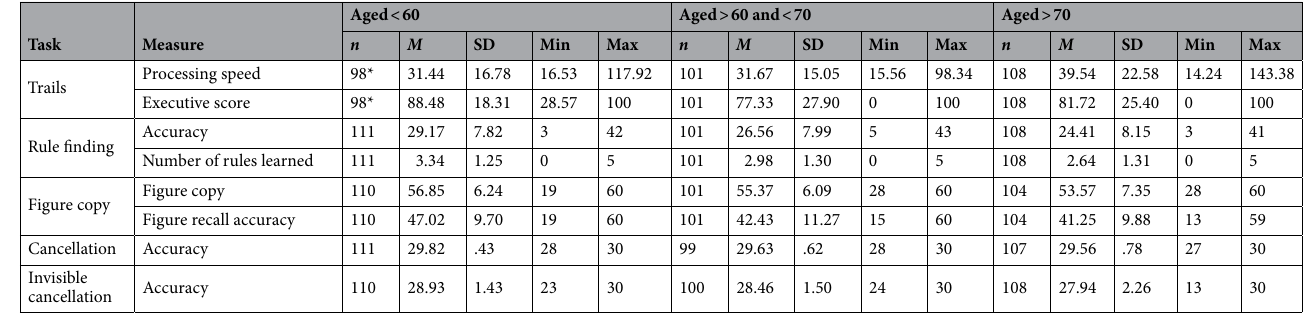
Table 5. Data for cut offs for impairment per age category (z-scores greater than 1.65 SD from the mean) for each OCS-Plus subtask. Oxford Cognitive Screen-Plus (OCS-Plus). This table can be used to